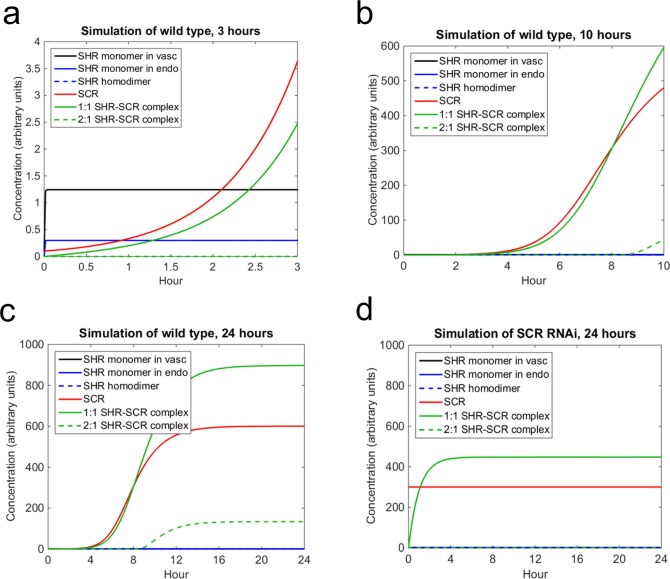
Mathematical model simulations of SHR and SCR illustrate how reduction of SCR affects the formation of SHR homodimer and SHR-SCR complex.(a, b, c) Model simulations of wild type showing how (a) SCR and the 1:1 SHR-SCR complex greatly increase in the first 3 hr, (b) SHR homodimer and the 2:1 SHR-SCR complex do not form until around 9 hr, (c) the entire system reaches a steady state between 18–24 hr. (d) Model simulations of SCR RNAi showing a reduction in SHR homodimer, SCR, 1:1 SHR-SCR complex, and 2:1 SHR-SCR complex levels after 24 hr. The model outcomes show SHR in the vasculature (black), SHR monomer in the endodermis (solid blue), SHR homodimer (dashed blue), SCR (red), 1:1 SHR-SCR complex (solid green), and 2:1 SHR-SCR complex (dashed green). Parameter values and initial conditions are given in Supplementary file 3. Source data is provided in Figure 5—source data 1 and 2.DOI:
http://dx.doi.org/10.7554/eLife.14770.02710.7554/eLife.14770.028Figure 5—source data 1.Sobol total effects indices computed for SHR-SCR mathematical model.DOI:
http://dx.doi.org/10.7554/eLife.14770.02810.7554/eLife.14770.029Figure 5—source data 2.Area measurements of vascular and endodermal cells.